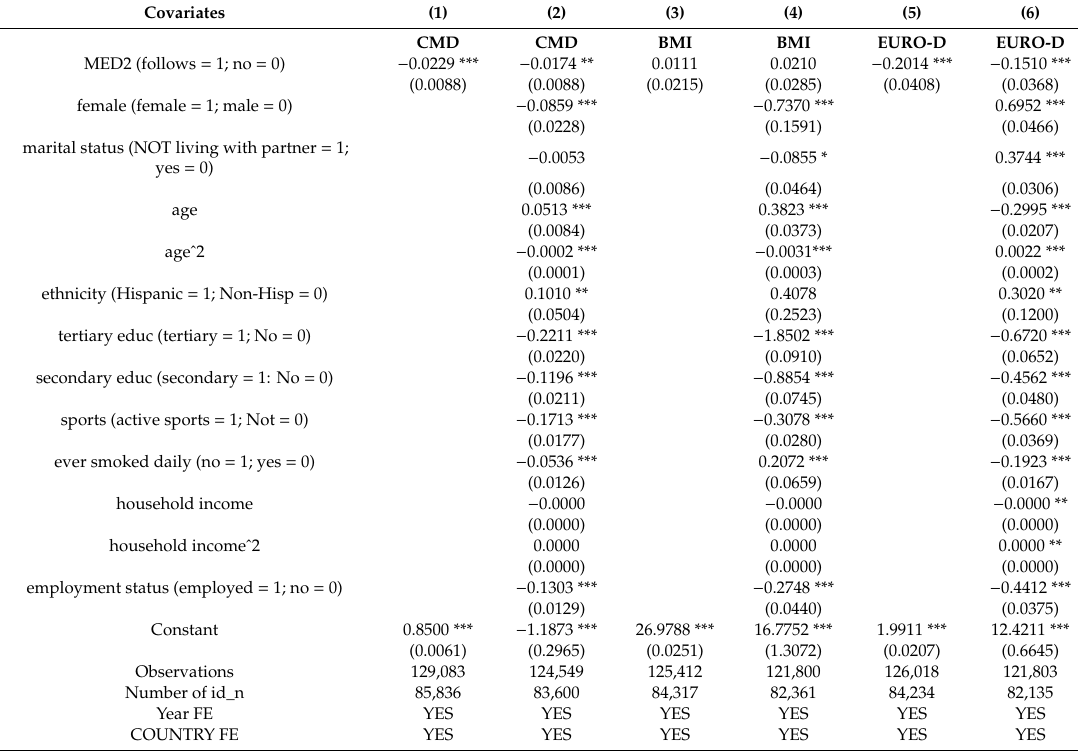
Table 5. Calibrating the Mediterranean diet variable for